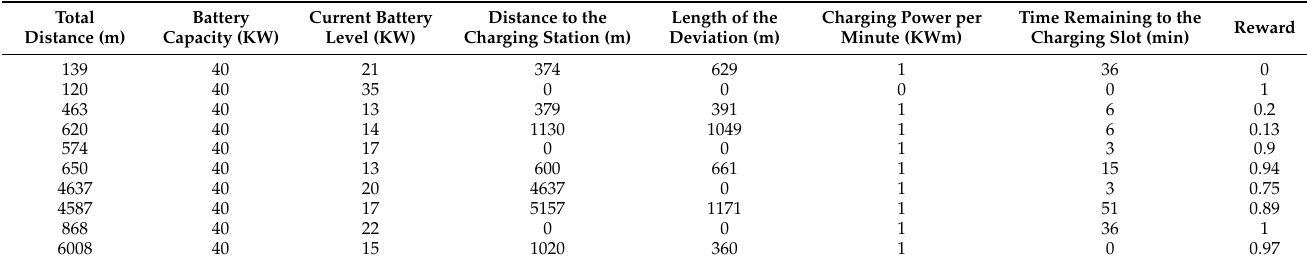
Table 1. Example of DQN model inputs and the associated